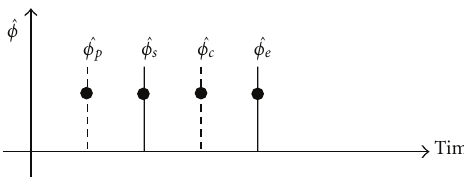
Figure 5: Tracking the Doppler within the OFDM